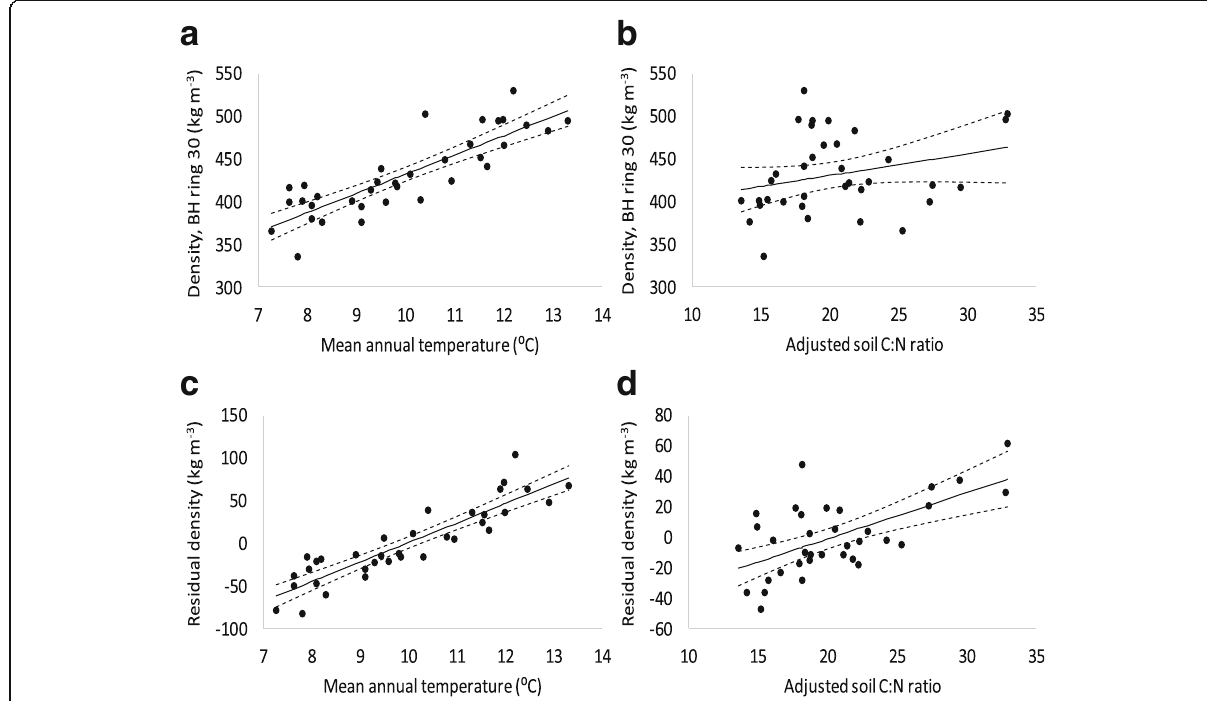
Fig. 1 Relationships between the predicted breast height wood density of ring 30 from pith and temperature and adjusted soil C:N ratio (i.e. C/ (N − 0.014). a Wood density vs mean annual temperature. b Wood density vs adjusted soil C:N ratio. c residuals from wood density= a + b × (adjusted soil C:N ratio) regression vs mean annual temperature. d Residuals from wood density = a + b × (mean annual temperature) regression vs adjusted soil C:N ratio